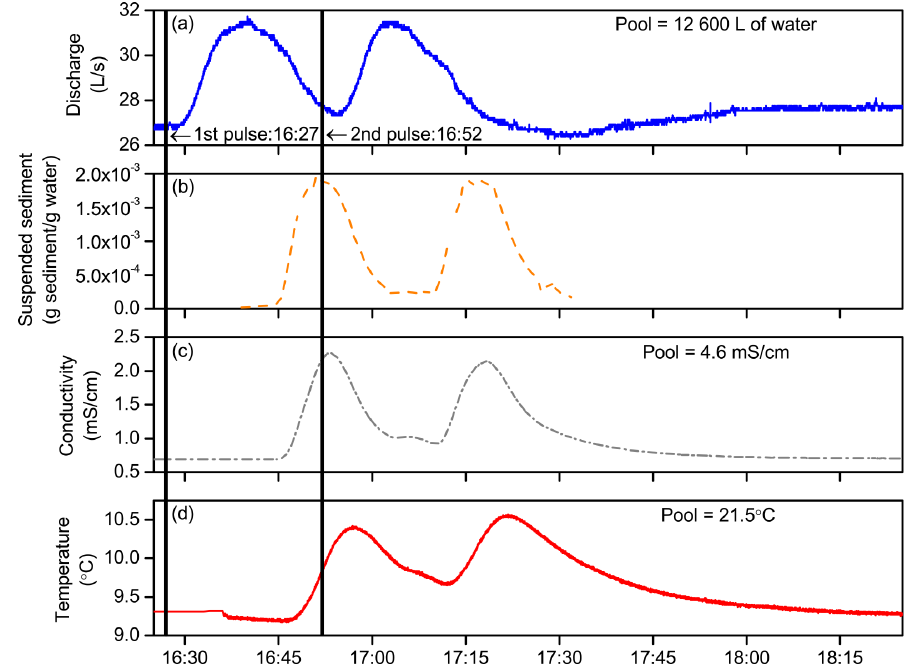
Figure 6. (a) Discharge, (b) suspended sediment, (c) electrical conductivity, and (d) temperature breakthrough curves at Freiheit Spring on 2 September 2010. Water was added to a pool at the edge of a sinkhole, and the water was heated to 21.5 ◦ C as salt was added. The water was emptied into the sinkhole, and breakthrough curves were monitored at Freiheit Spring approximately 95m away.